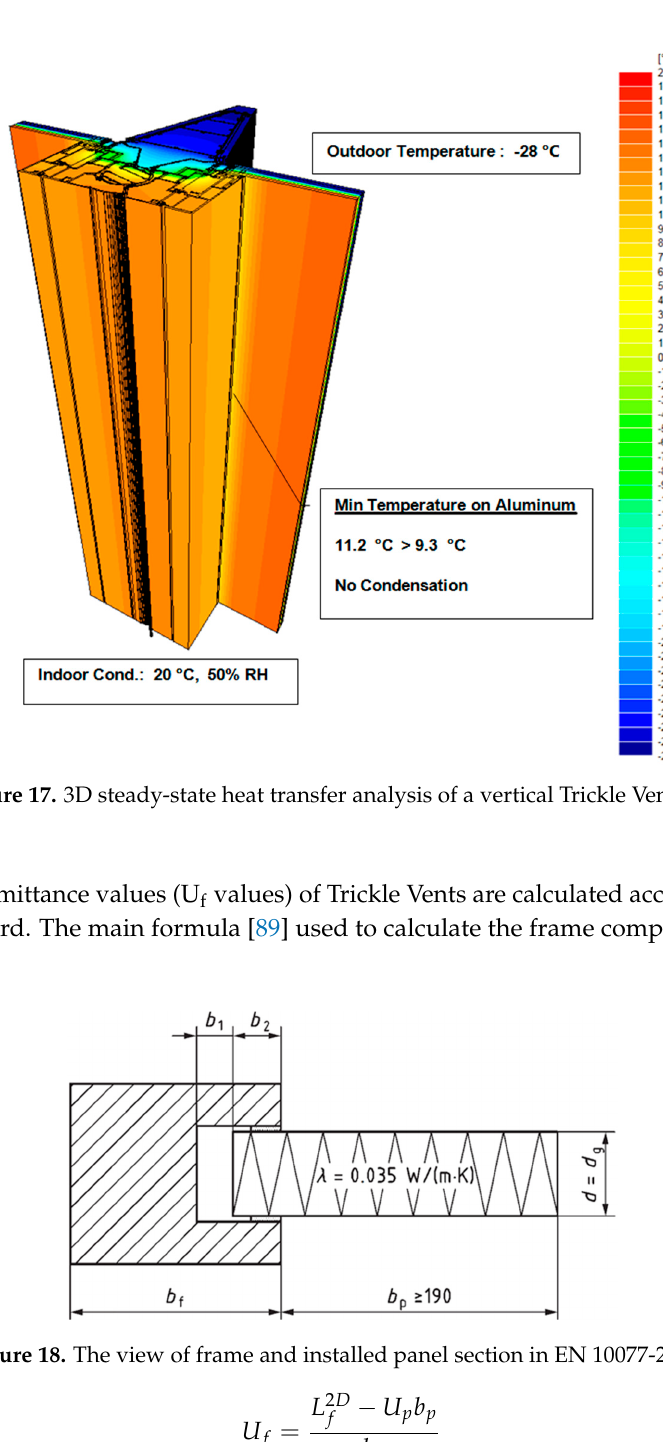
Figure 18. The view of frame and installed panel section in EN 10077-2 [65].